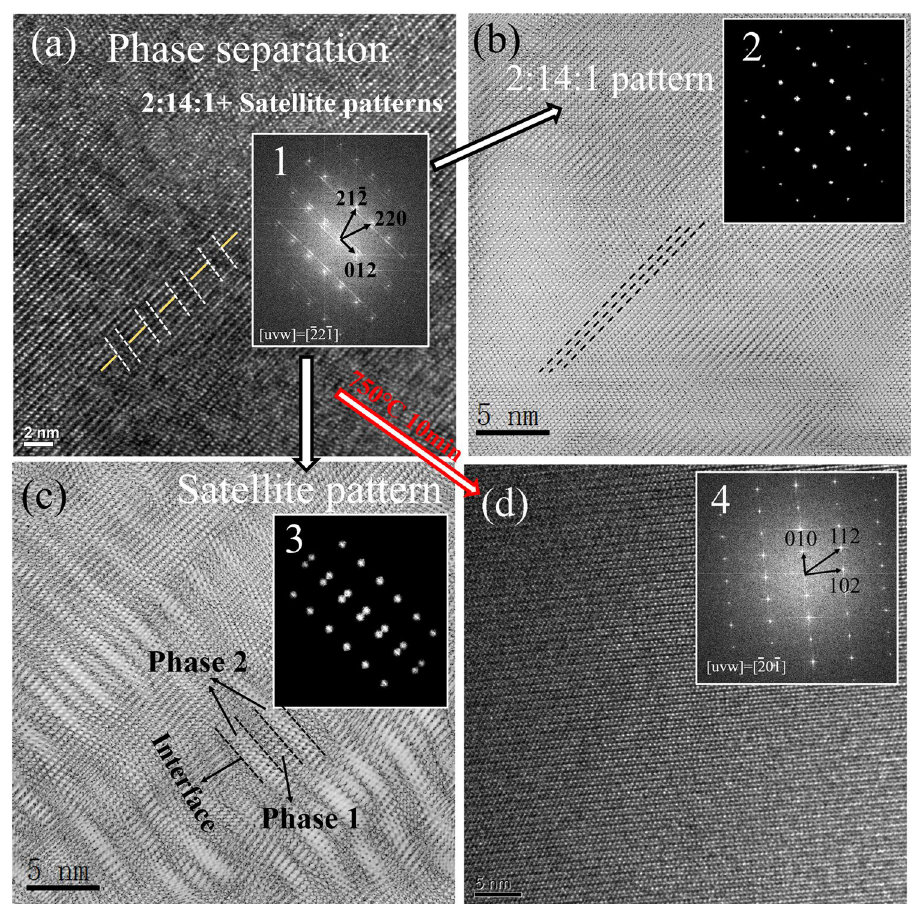
Figure 5. ( a ) HRTEM image and FFT image (inset 1) of the 2:14:1 phase in the as-cast x = 0.3 sample (the FFT image pattern can be divided into 2 patterns, i.e. a 2:14:1 main pattern (b inset 2) and a satellite pattern (b inset 3)); ( b ) the inverse FFT image for the main pattern in b inset 2; ( c ) the inverse FFT image for the satellite pattern in c inset 3; ( d ) the HRTEM image and FFT image (inset 4) of 2:14:1 phase in the as-cast x = 0.3 sample heat treated at 750 °C for 10